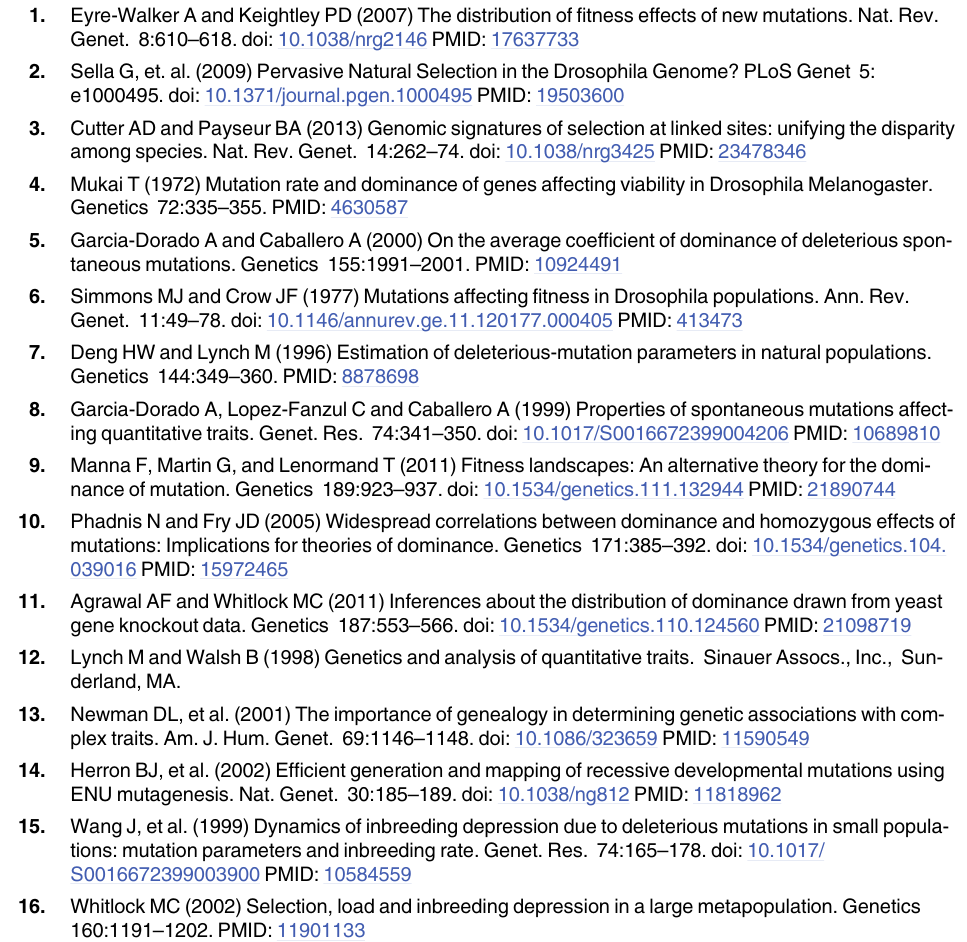
S2 Table. B Rsynon data table for fourfold degenerate synonymous sites. All analyses are repeated for a B statistic computed using only fourfold degenerate synonymous variants R assumed to be under little or no selection. 1KG shows slight signi fi cance when testing all genes, remains very close to one, potentially indicating spurious signi fi cance. however the value of B R Naively, this provides a control for the results derived from nonsense and damaging variants above in the absence of selection or linkage to selected